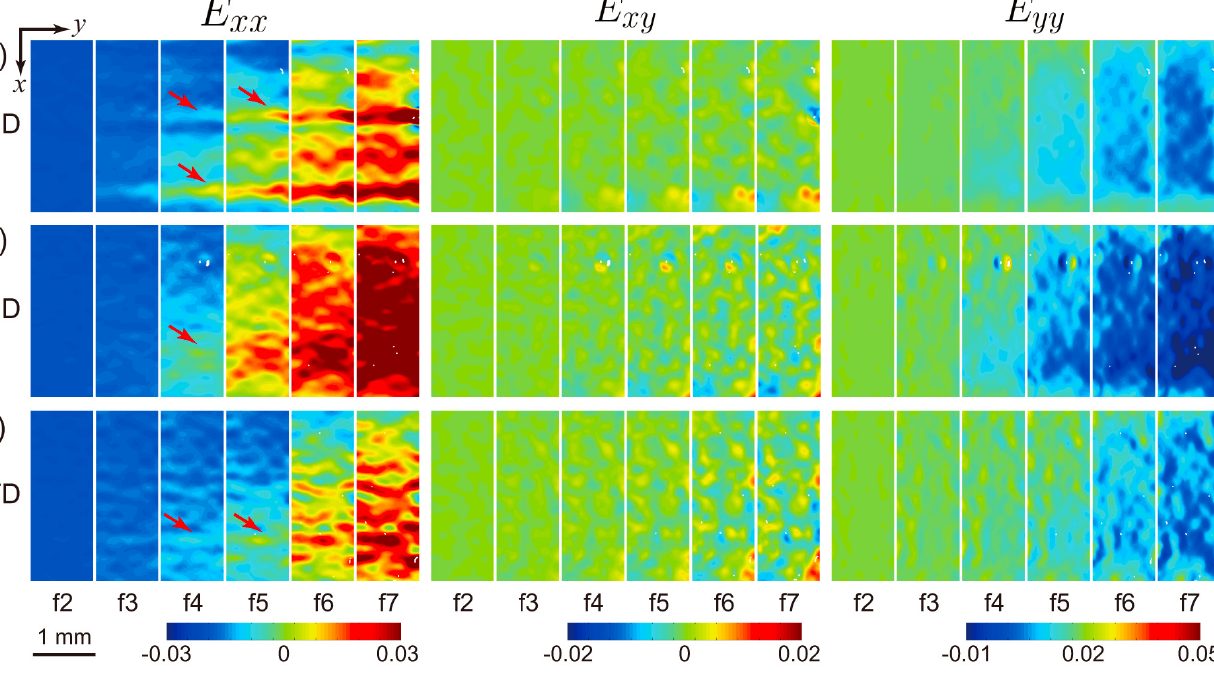
Figure 9. Snapshots of 2D strain fields of E xx , E xy and E yy for quasi-static tensile loading along ED ( a ), ND ( b ) and TD ( c ). The low-amplitude strain localizations are marked by red arrows. SEM fractographs of the recovered CNT/2024Al composites under quasi-static